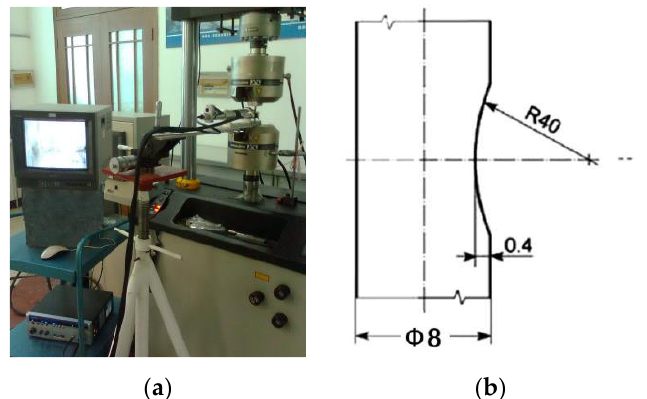
Figure 3. Observation of LCF damage: ( a ) Observation system for fatigue damage; ( b ) Fatigue specimens with an arc surface.